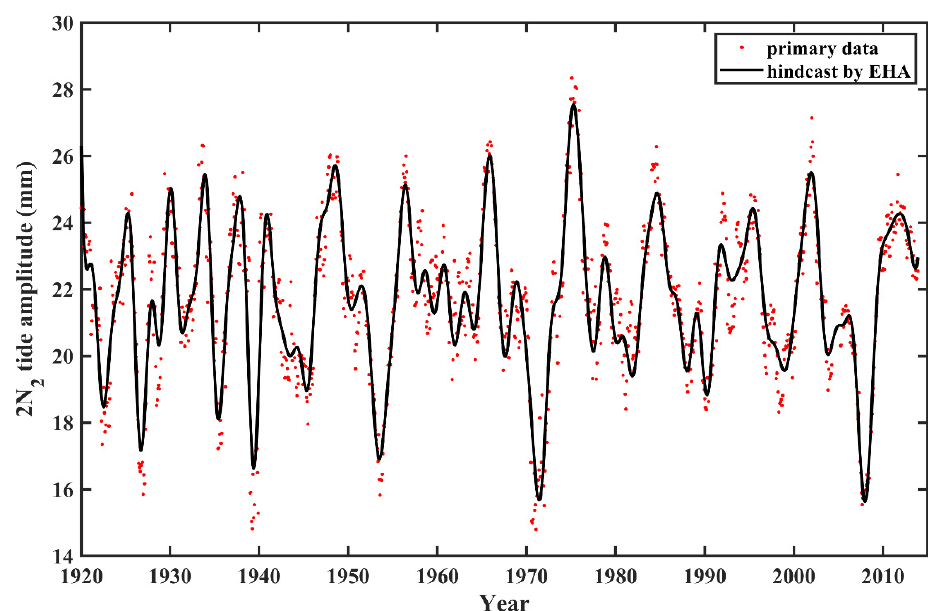
Figure 3. Same as Figure 2 but for the 2N 2 tide.